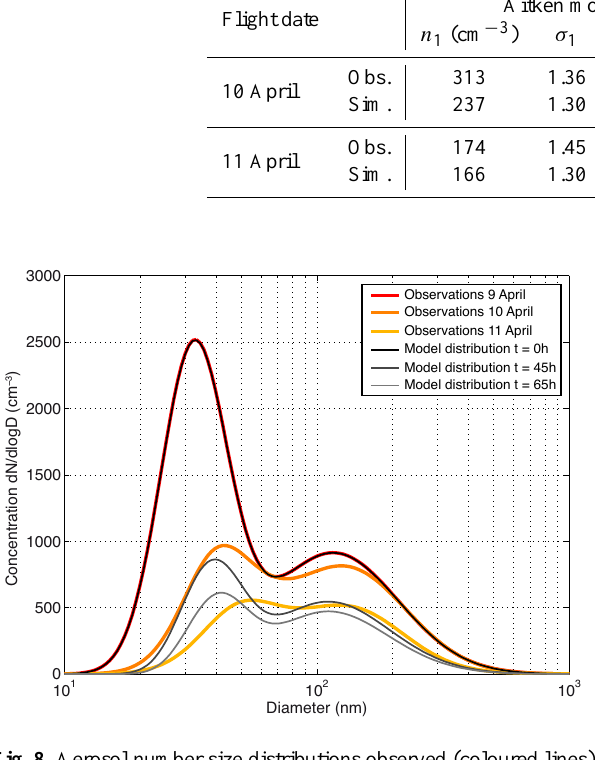
Fig. 8. Aerosol number size distributions observed (coloured lines) and simulated with a coagulation model (grey level lines) for flights on 9, 10 and 11 April. t = 0 corresponds to the mean FLEXPART age for the measurements of the plume on 9 April. See text for de-